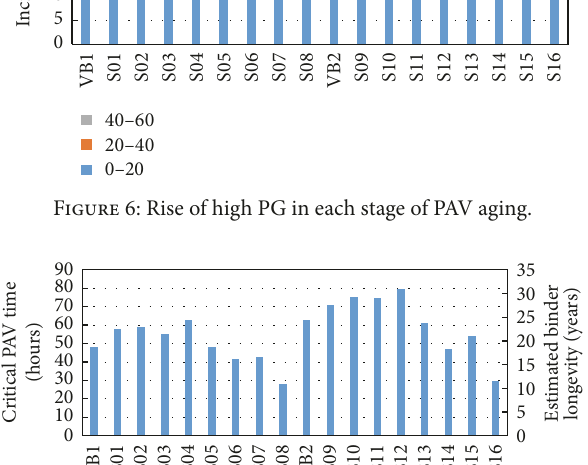
Figure 7: Critical PAV time (left axis) and estimated longevity (right axis) of